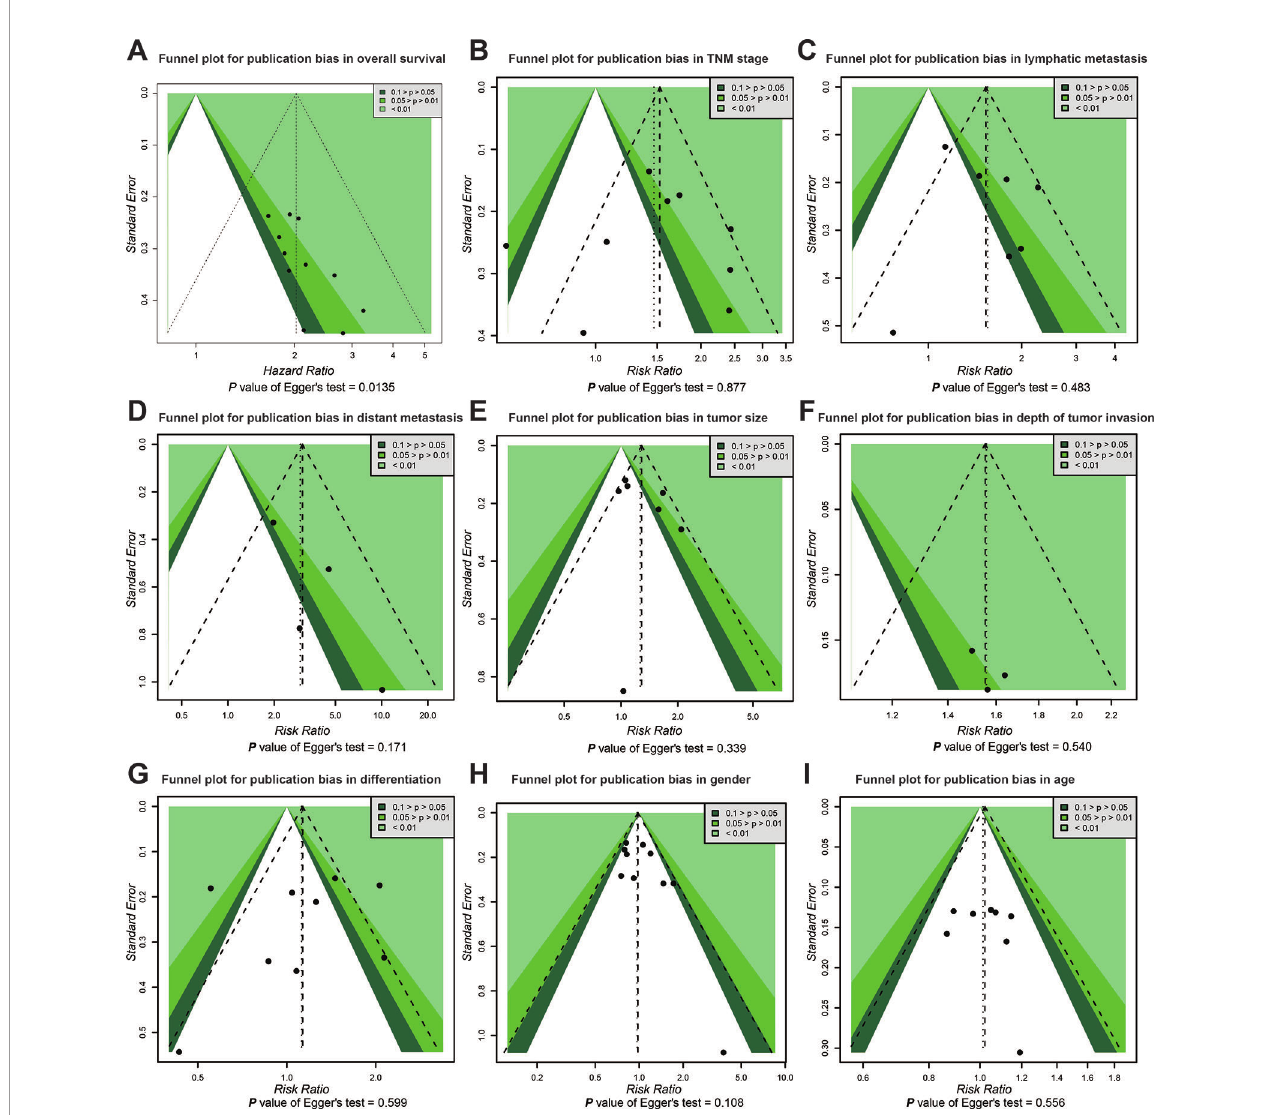
FIGURE 4 | Funnel plot for publication bias in overall survival and clinicopathological characteristics. (A) overall survival (OS), (B) tumor, node, metastasis (TNM) stage, (C) lymphatic metastasis, (D) distant metastasis, (E) tumor size, (F) depth of tumor invasion, (G) differentiation, (H) gender, and (I)